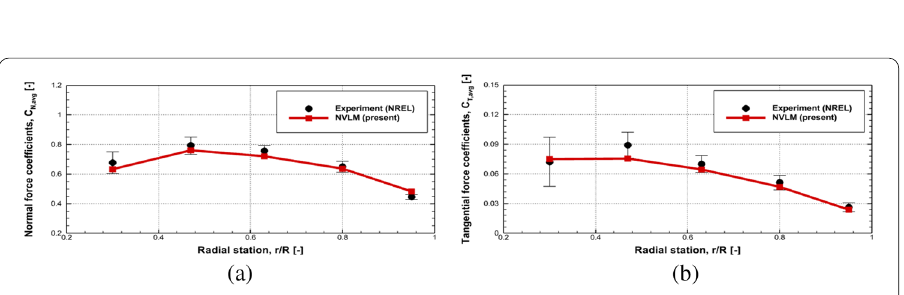
Fig. 15 Comparison of time-averaged force coefficients for V tangential force coefficients